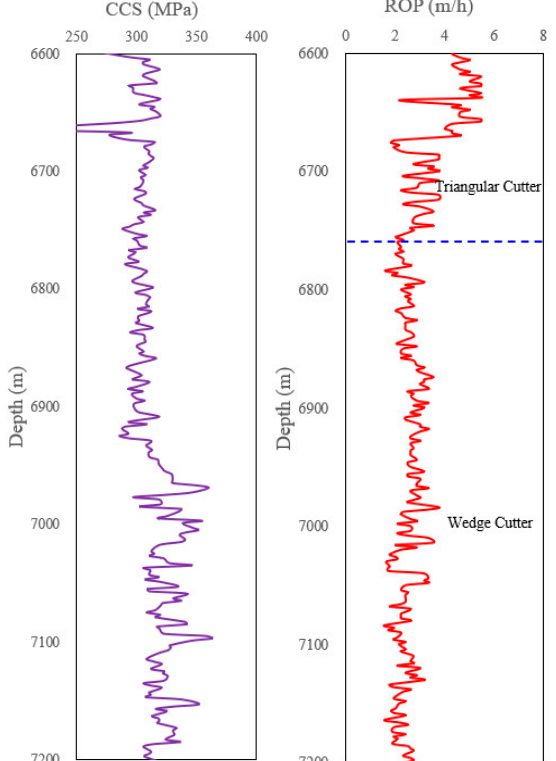
Figure 10. Variation curves of the CCS and ROP with well depth. On the left is the CCS curve with depth, on the right is the ROP curve with depth.